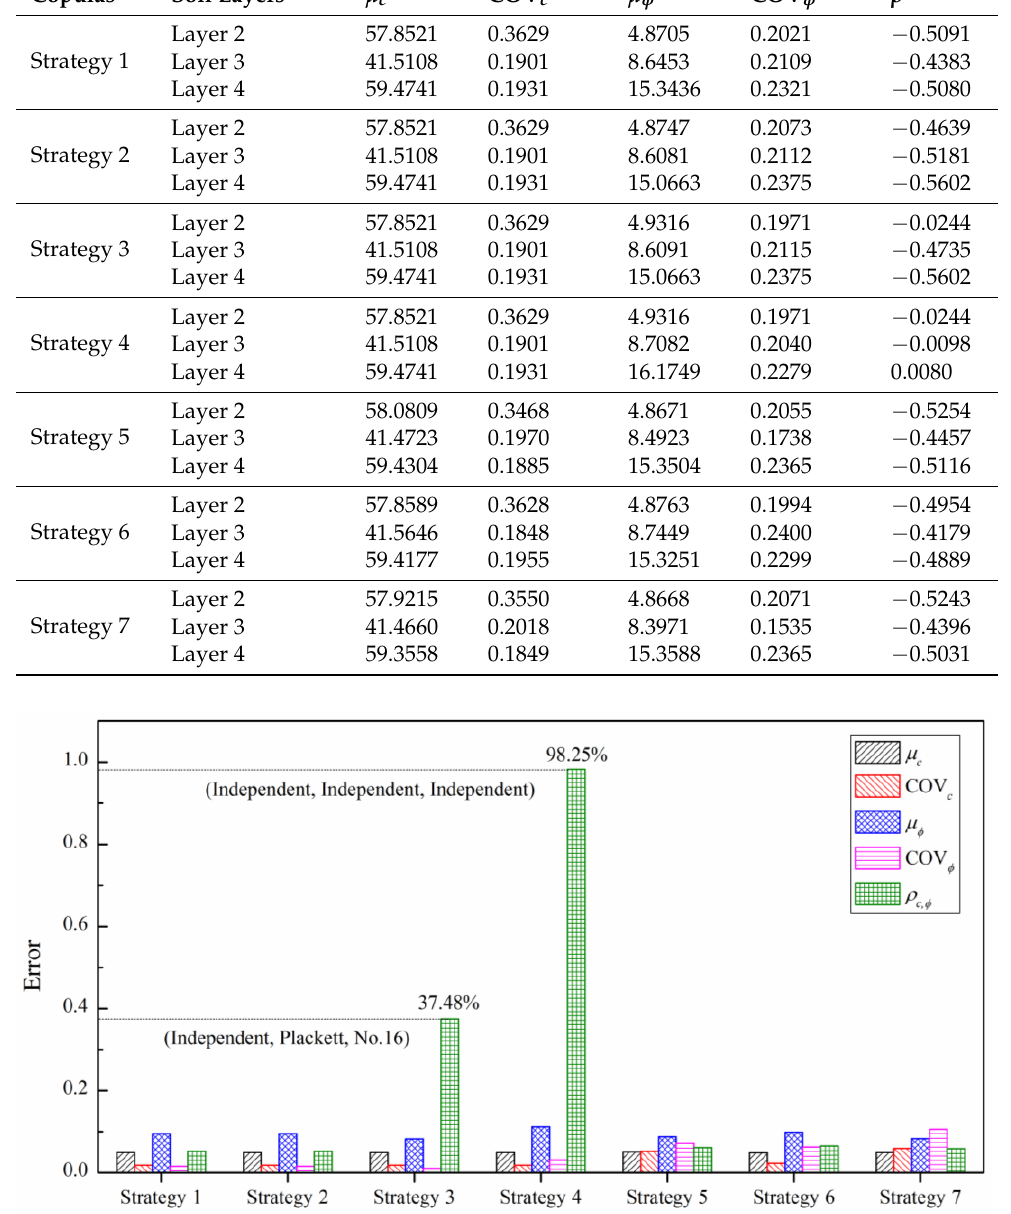
Figure 23. A typical realization of transversely anisotropic CCRF yielded by strategy 7. ( a ) Random field of c. ( b ) Random field of ϕ.